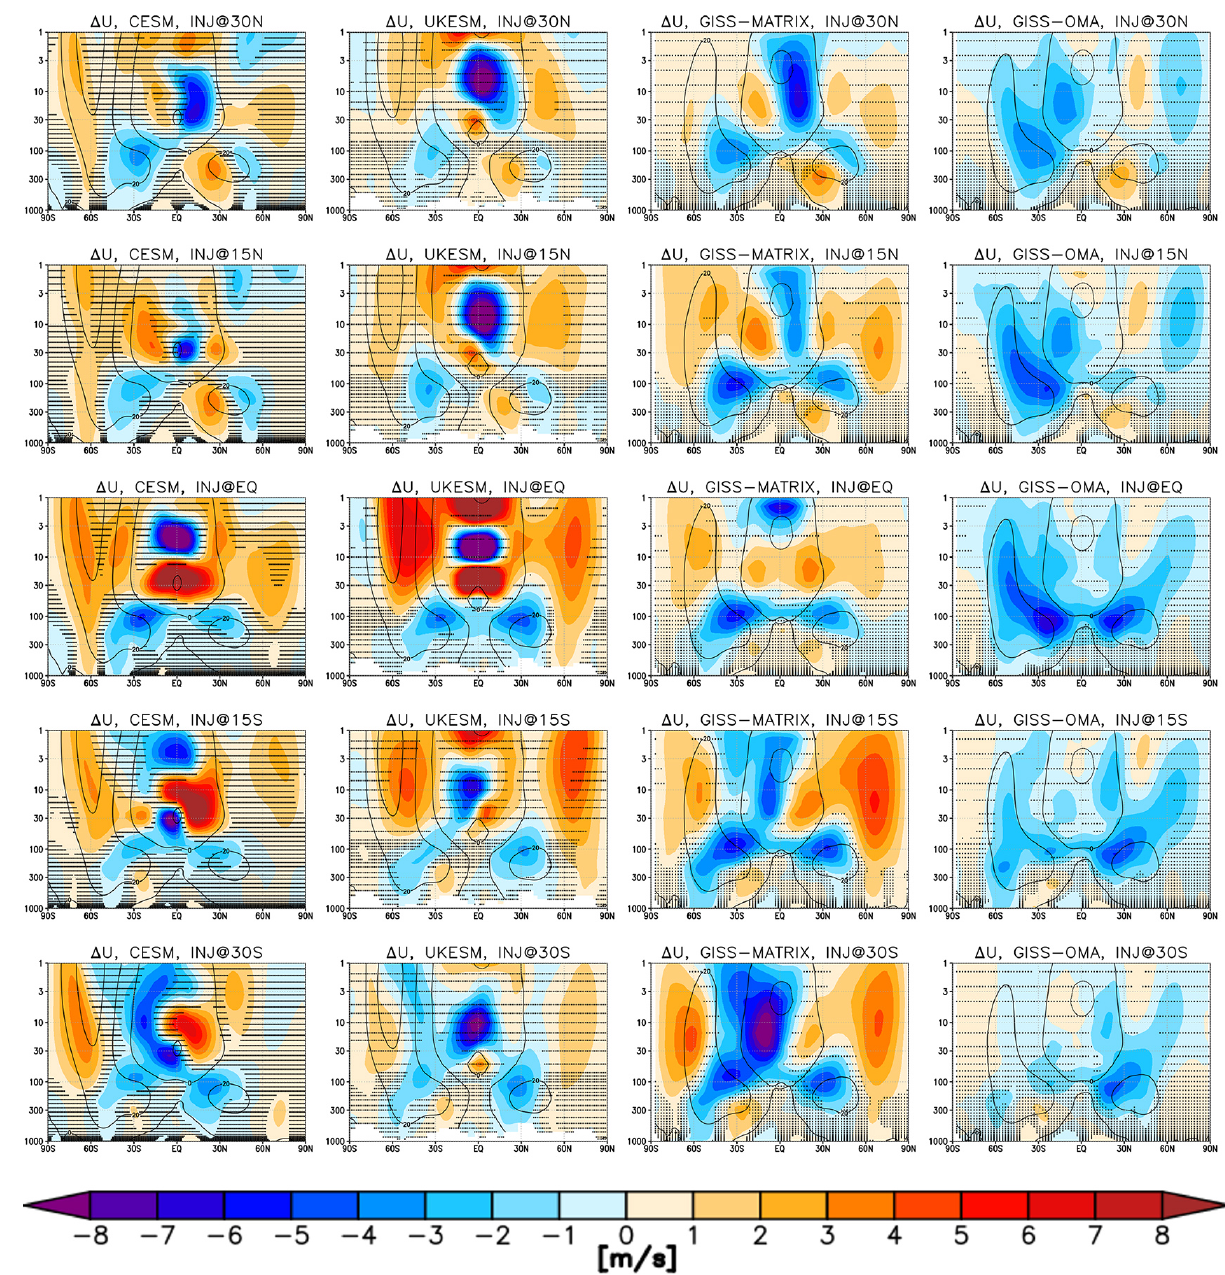
Figure 11. As in Fig. 5 but for zonal wind changes [ms − 1 ]. Stippling as in Fig.